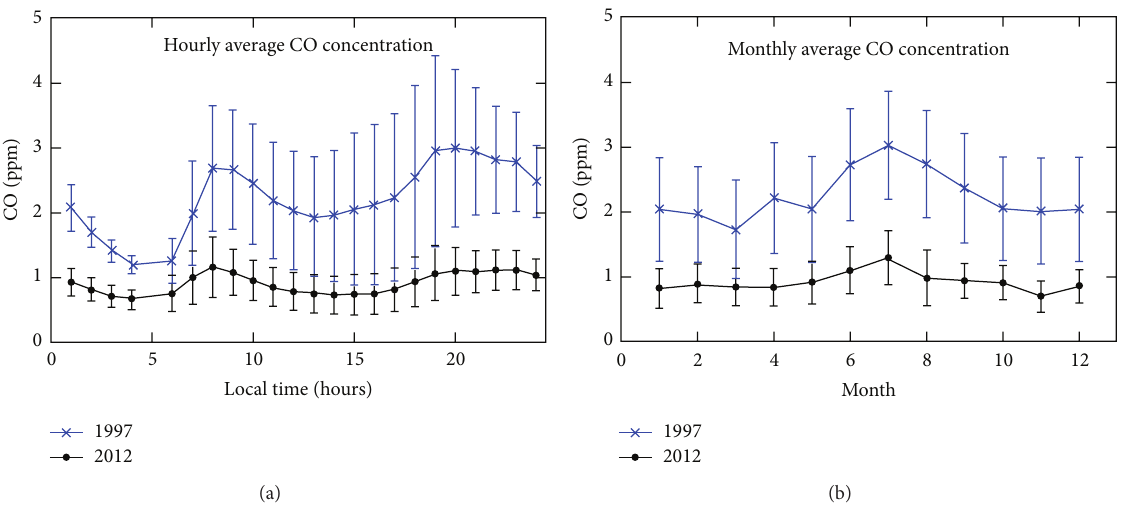
Figure 4: (a) Hourly and (b) monthly averages of CO concentration for the MRSP for the years 1997 (blue) and 2012 (black). 10 stations were considered for 1997 and 14 stations for 2012. Error bars represent the standard